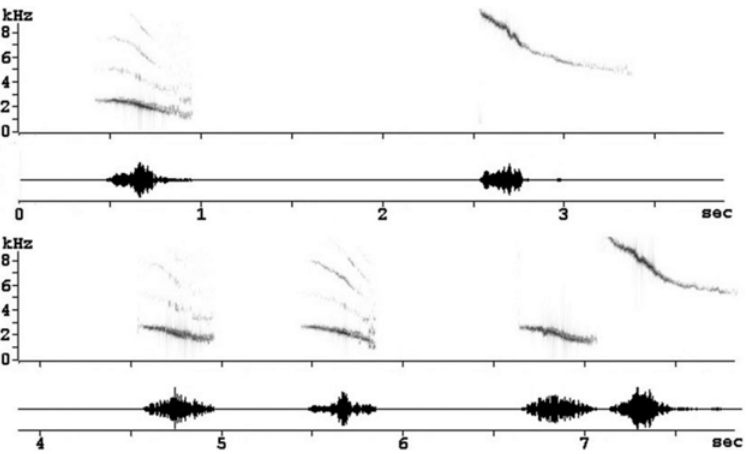
Figure 4. Example of a natural sequence of whistles sung by a wild starling in the field. Sonogram (upper trace) and spectrogram (lower trace) are time aligned